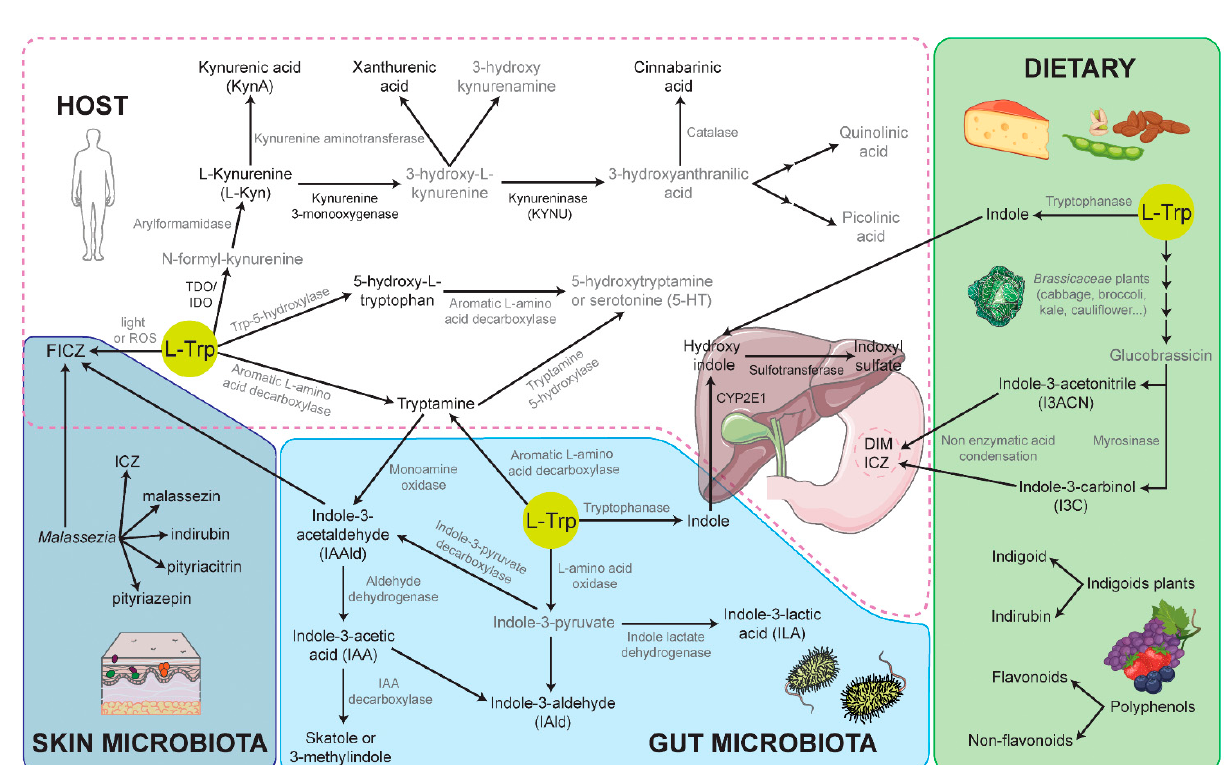
Figure 3. Summary of natural AHR agonist synthesis pathways in mammalian cells, associated microbiota, and dietary plants. HOST—endogenous L-tryptophan (L-Trp) metabolism via the L-kynurenine (L-Kyn), serotonin (5-HT), and tryptamine pathways; indoxyl synthesis in the liver from the diet- or microbial-derived indoles; gastric acid condensation of dietary indoles pro-ligands produces high-affinity indolic agonists; 6-formylindolo [3,2-b]carbazole (FICZ) is generated by L-Trp photo-oxidation, L-Trp chemical-oxidation, or by enzymatic deamination of tryptamine that yields the precursor indole-3-acetaldehyde (IAAld). SKIN MICROBIOTA—the AHR agonist, synthesized by skin-resident microbiota, such as Malassezia yeast species. GUT MICROBIOTA—indole-derived AHR agonists, provided by microbial metabolism of L-Trp, which can be further metabolized to indoxyl by the host. DIETARY—polyphenol- and indole (e.g., Brassicaceae plants)-rich foods provide exogenous ligands, either as direct AHR ligands or as pro-ligands that can be converted to AHR ligands by the host. L-Trp metabolic routes have been designed according to the KEGG Pathway Database (https://www.genome.jp/ kegg/pathway/map/hsa00380.html (accessed on 8 October 2021) and PathBank (https://pathbank.org/view/SMP0000063 (accessed on 8 October 2021)). AHR ligands or enzymes regulated by AHR are indicated in black, and